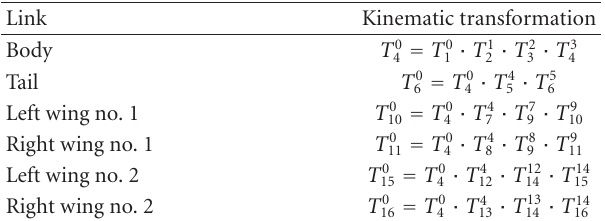
Table 2: Kinematic Transformation for each link of the dragonfly. Link Kinematic transformation